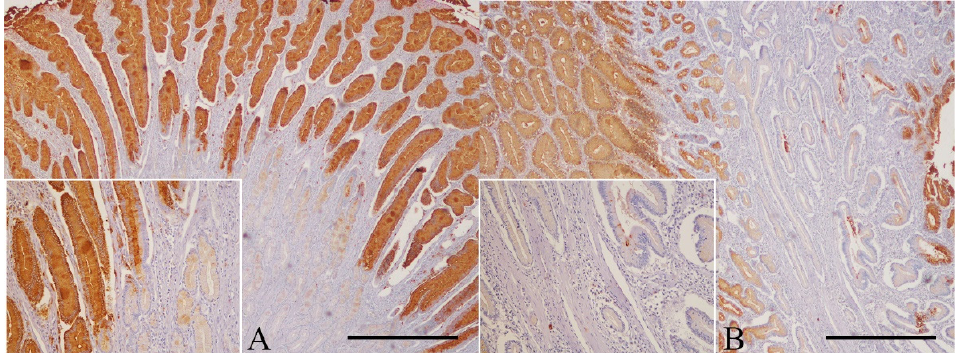
Figure 3. Gastric polyps. Immunohistochemistry for TFF1 counterstained with Mayer ´ s hematoxylin. ( A ) Hyperplastic polyp: although with different intensity, TFF1 expression is observed in all epithelial components (bar = 500 µ m). Inset shows a higher magnification of TFF1 immunostaining covering superficial epithelium and antral glands (200 × ). ( B ) Inflammatory polyp: some glands do not display TFF1 expression, in contrast with the strong immunolabeling of superficial gastric mucosa (bar = 500 µ m). Inset high shows the reduced expression of TFF1 in the antral glands (200 ×